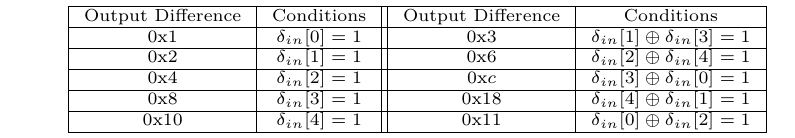
Table 2: Summary of conditions for special output differences of χ